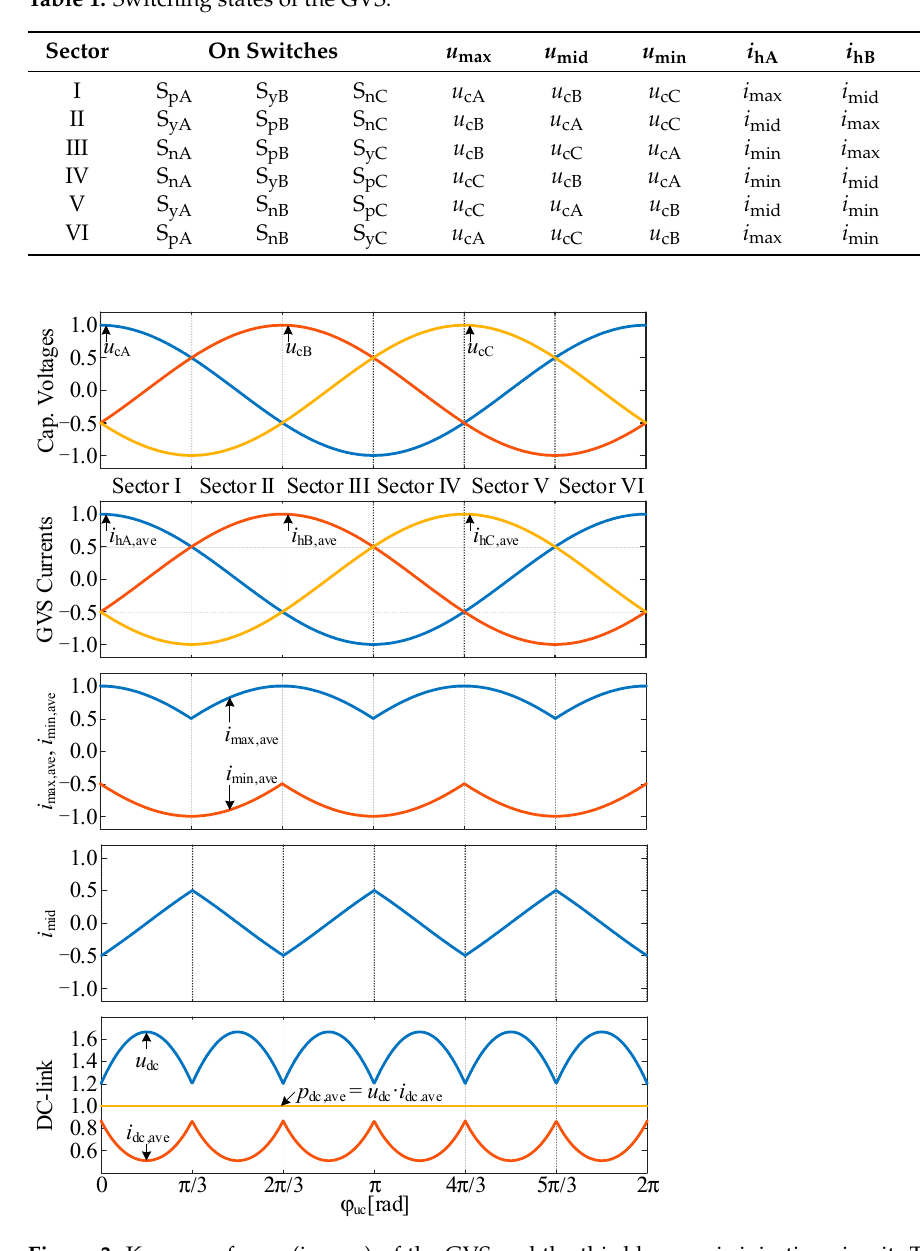
Figure 3. Key waveforms (in p.u.) of the GVS and the third harmonic injection circuit. The word “ave” in the subscript denotes the low-frequency component of the corresponding variable in each switching period. φ uc is the phase angle of the capacitor voltage vector.